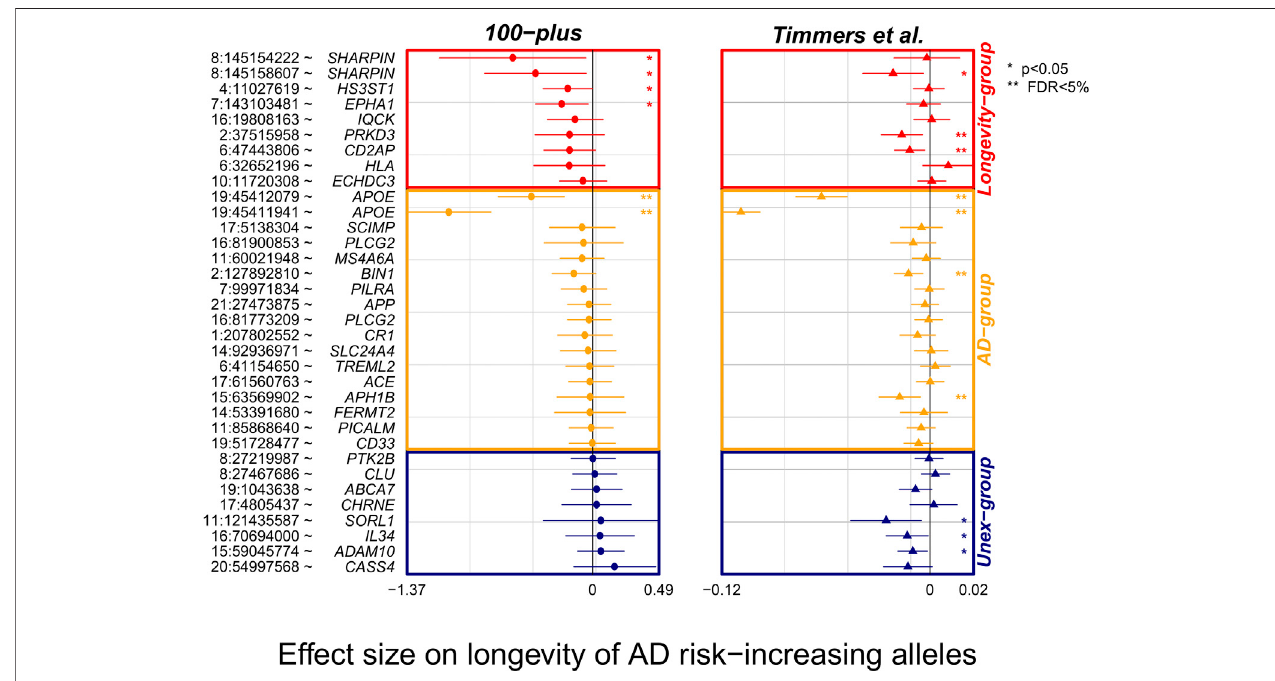
FIGURE 2 | Forest plot of association statistics of AD-variants in our study and the largest GWAS of parental longevity. The plot shows the association of AD- variants inourstudyand thelargest by-proxy GWASonparental longevity(Timmerset al.,2019).Theassociationstatisticsof34/38variants wereavailablefrom publicly availablesummarystatisticsofTimmersetal.study.Plottedeffect-sizesarewithrespecttotheAD-riskincreasingallele.Thus,anexpecteddirectionofeffectisshownfor variants with a negative estimate. Nominally signi fi cant associations with AD ( p < 0.05) are annotated with an asterisk (*), and signi fi cant associations after FDR correction are annotated with two asterisks